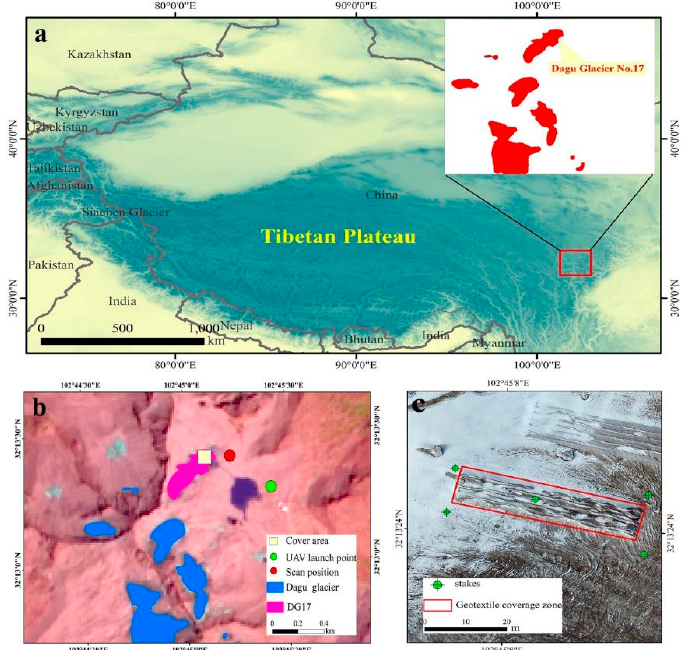
Figure 1. Study site. ( a ) Location of DG17 in the eastern Qinghai-Tibetan Plateau. ( b ) The extent of the monitored area with artificial melt reduction in DG17. ( c ) The measuring point network in 2020, a geotextile boundary was added.